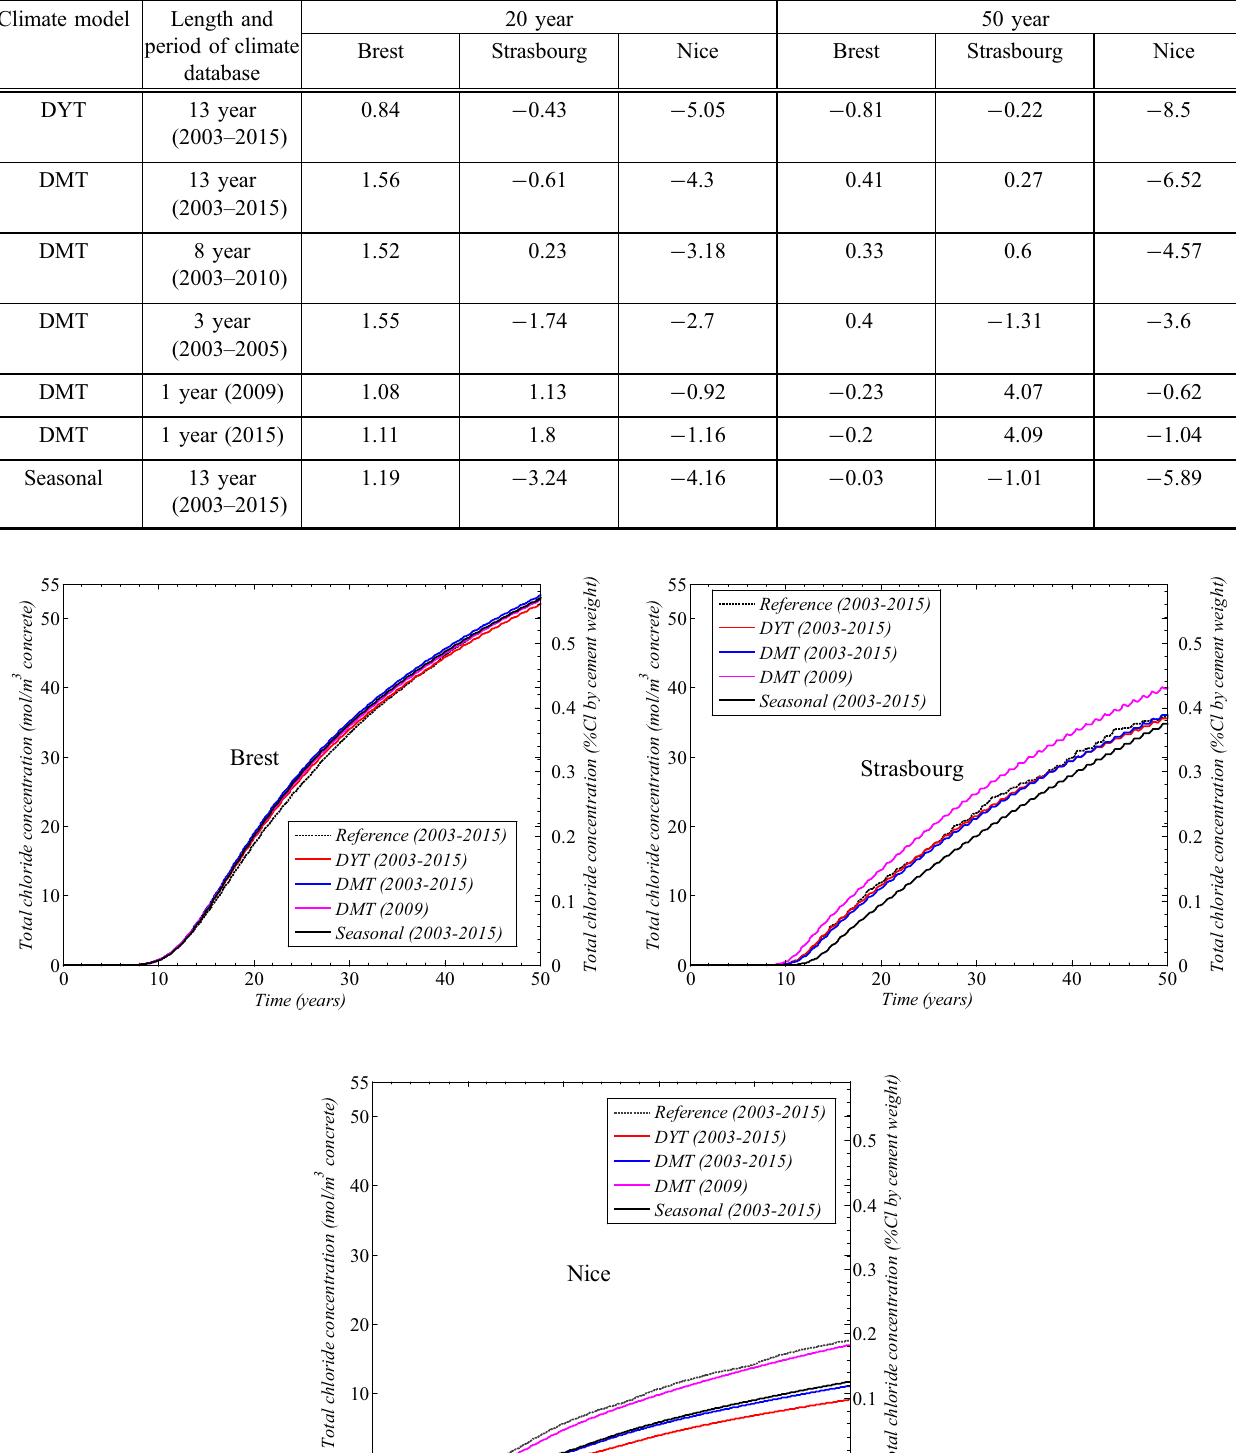
Table 4 Mid- and long-term differences between chloride concentrations assessed with the climate database and models (mol/m 3 concrete).